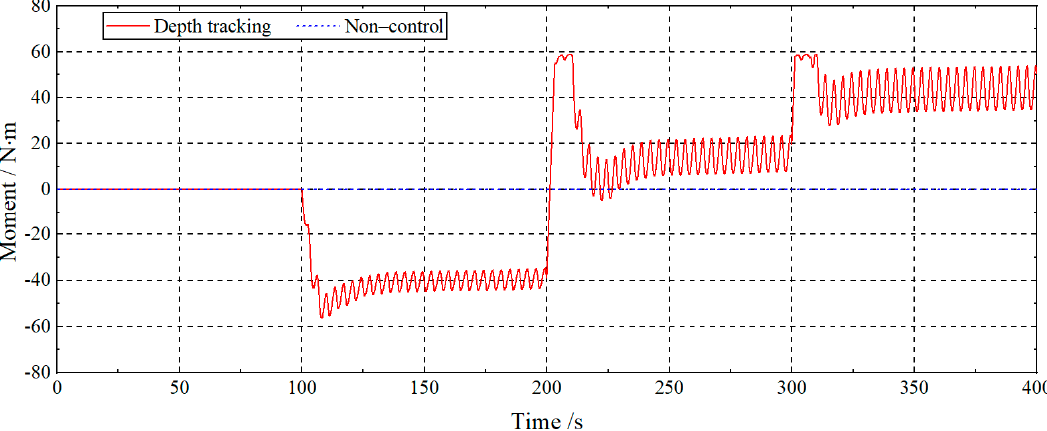
Figure 15. Time history of moment caused by the shifting weight.